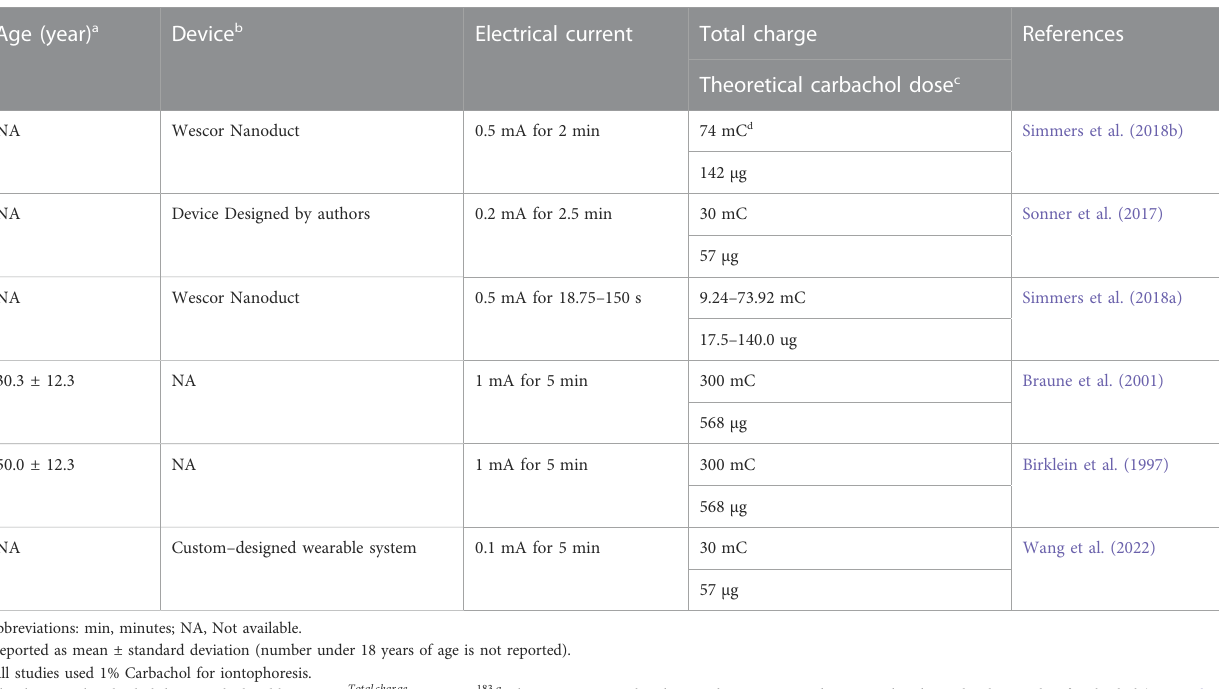
TABLE 5 Carbachol dose for sweat induction by